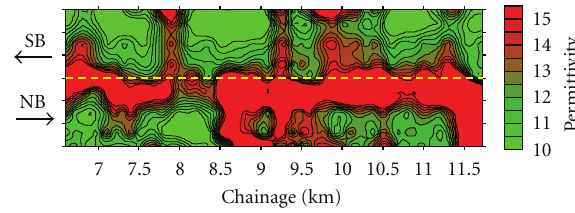
Figure 1: Subgrade permittivity contour.